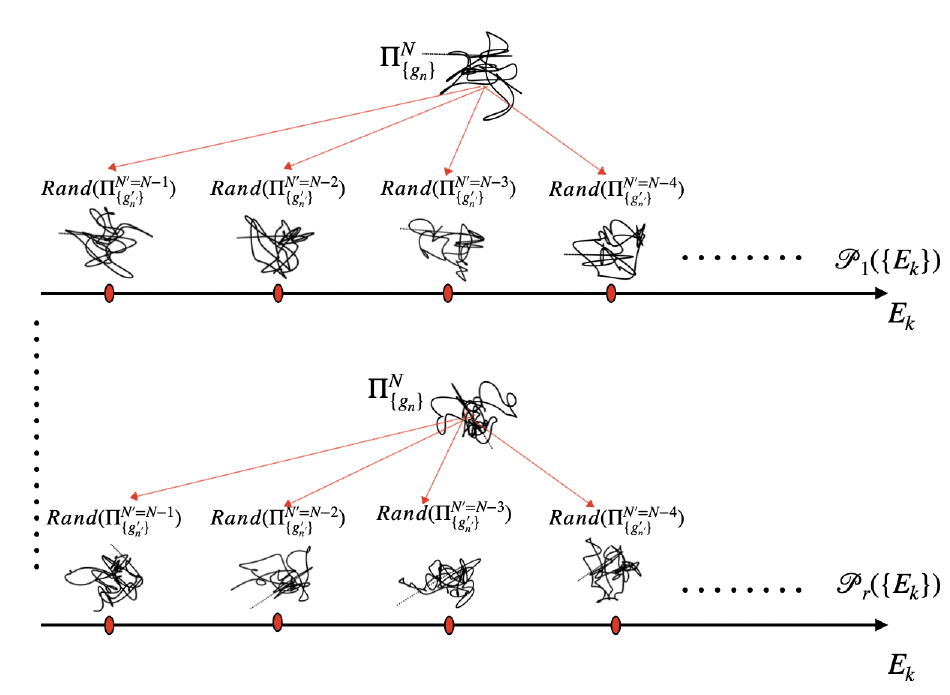
Figure 11 . Picture of the random microstates energy trajectories P ( { E k } )